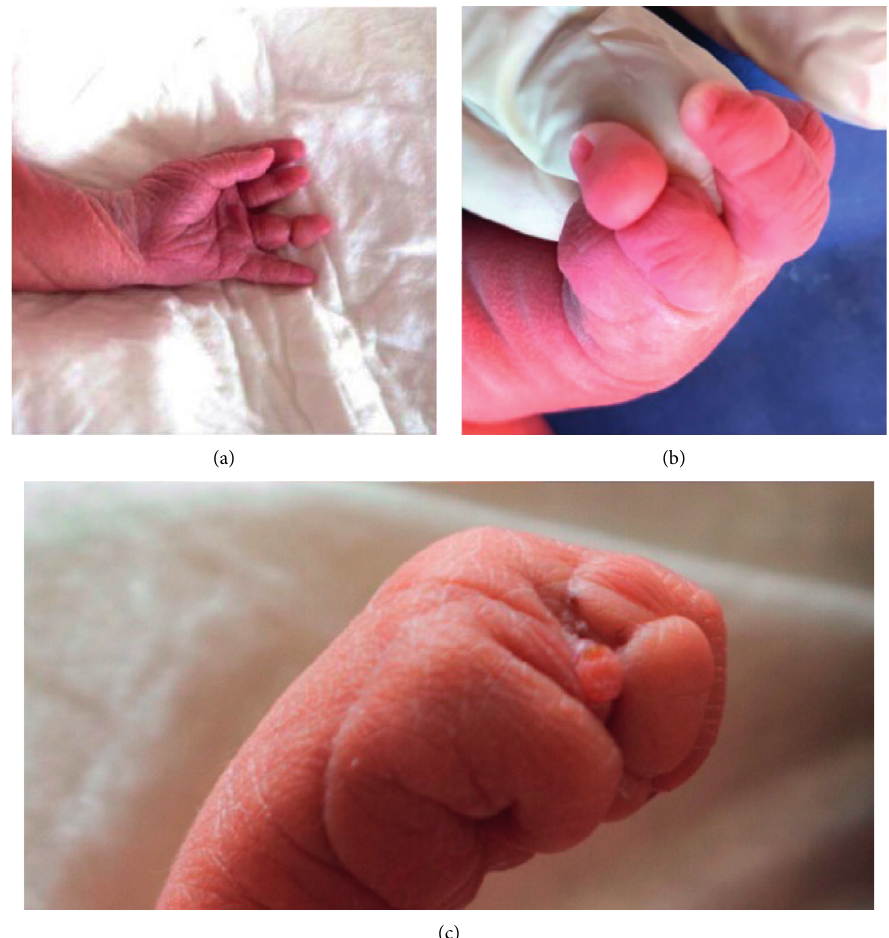
Figure 1: Left hand. Single palmar crease, deep annular sulcus in the fourth finger deep (a); annular sulcus in the fourth finger and interdigital bridges (b); annular sulcus